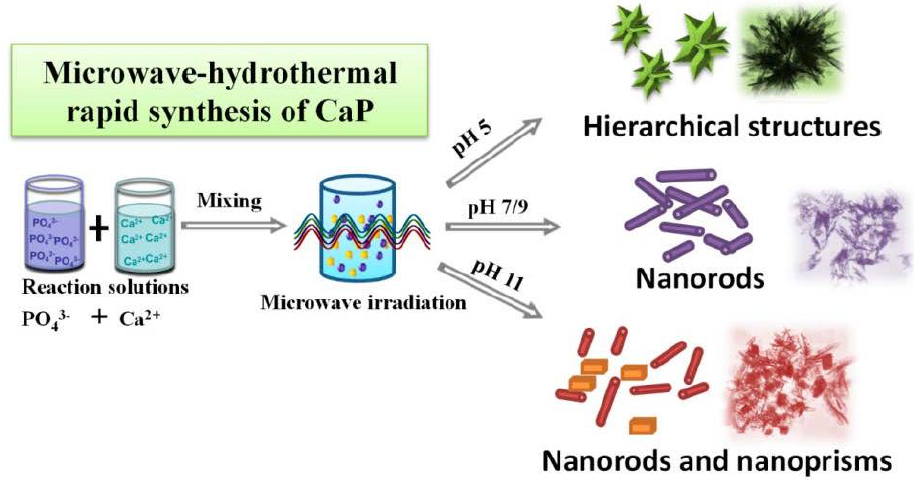
Figure 4. Schematic illustration for the synthesis of calcium phosphate nanostructures with the microwave-assisted hydrothermal method under different pH